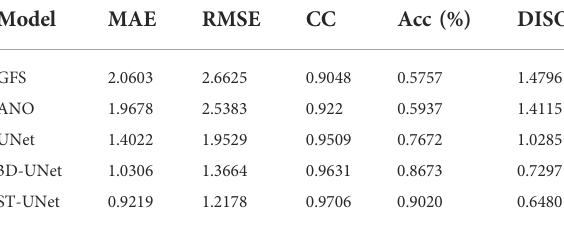
TABLE 3 The performance of bias correction for 2-m temperature of 24 h forecast on the test set. Model